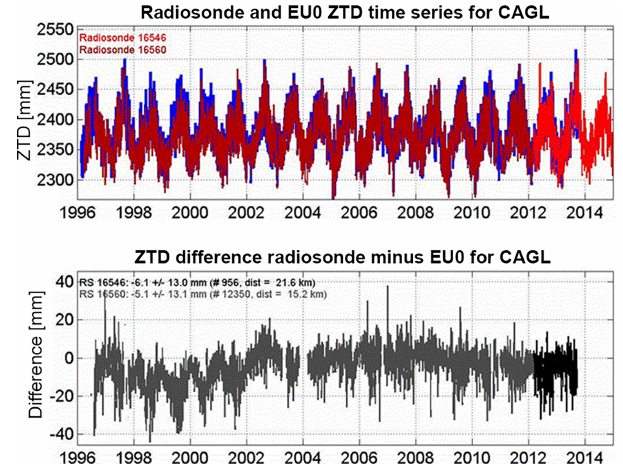
Figure 9. EPN station CAGL (Cagliari, Sardinia Island, Italy). (a) Radiosondes (in red) and GPS (in blue) ZTD time series. (b) ZTD differences calculated as RS minus